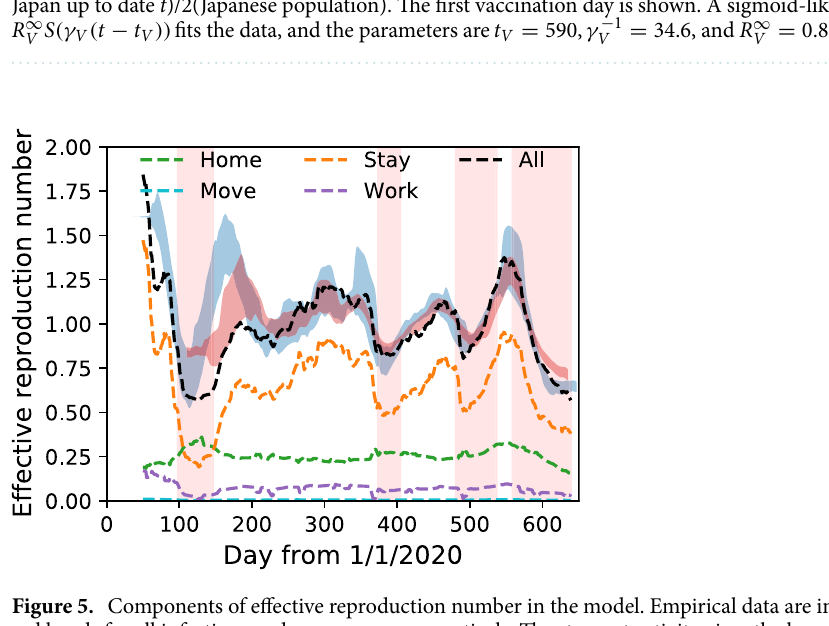
R ∞ V = 34.6 , and V = 0.817 .